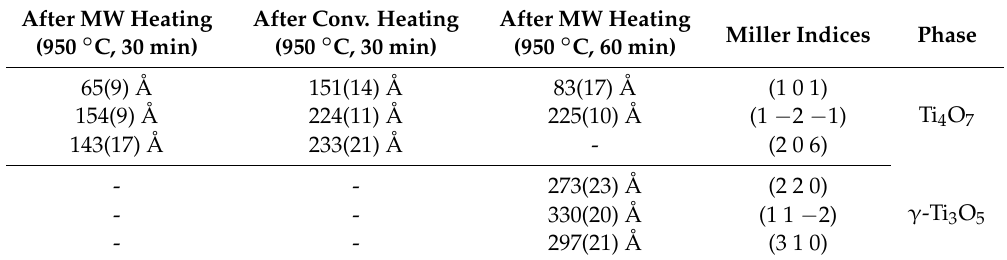
Table 1. Crystallite diameters of the synthesized samples.